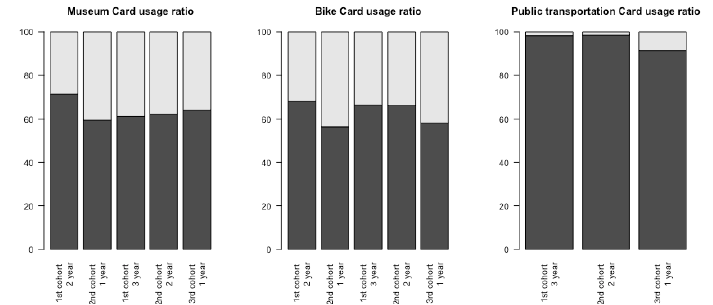
Fig. 10. Bar plot of the usage of each service year by